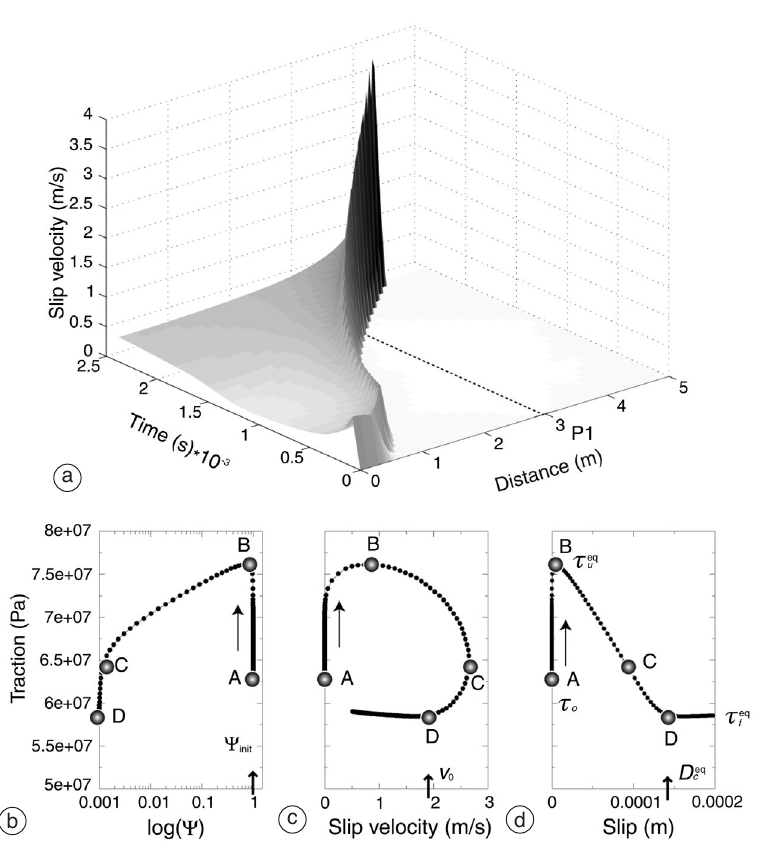
Fig. 1a-d. a) The spatio-temporal evolution of slip velocity during the dynamic rupture propagation on a ho- mogeneous fault. The initial and constitutive parameters used for these calculations are listed in table II. The bot- tom panels show the traction evolution as a function of state variable (b), slip velocity (c) and slip (d) for a tar- get point P1. Ψ init in (b) represents the initial value of the state variable; v displacement reaches the critical slip weakening distance D c eq